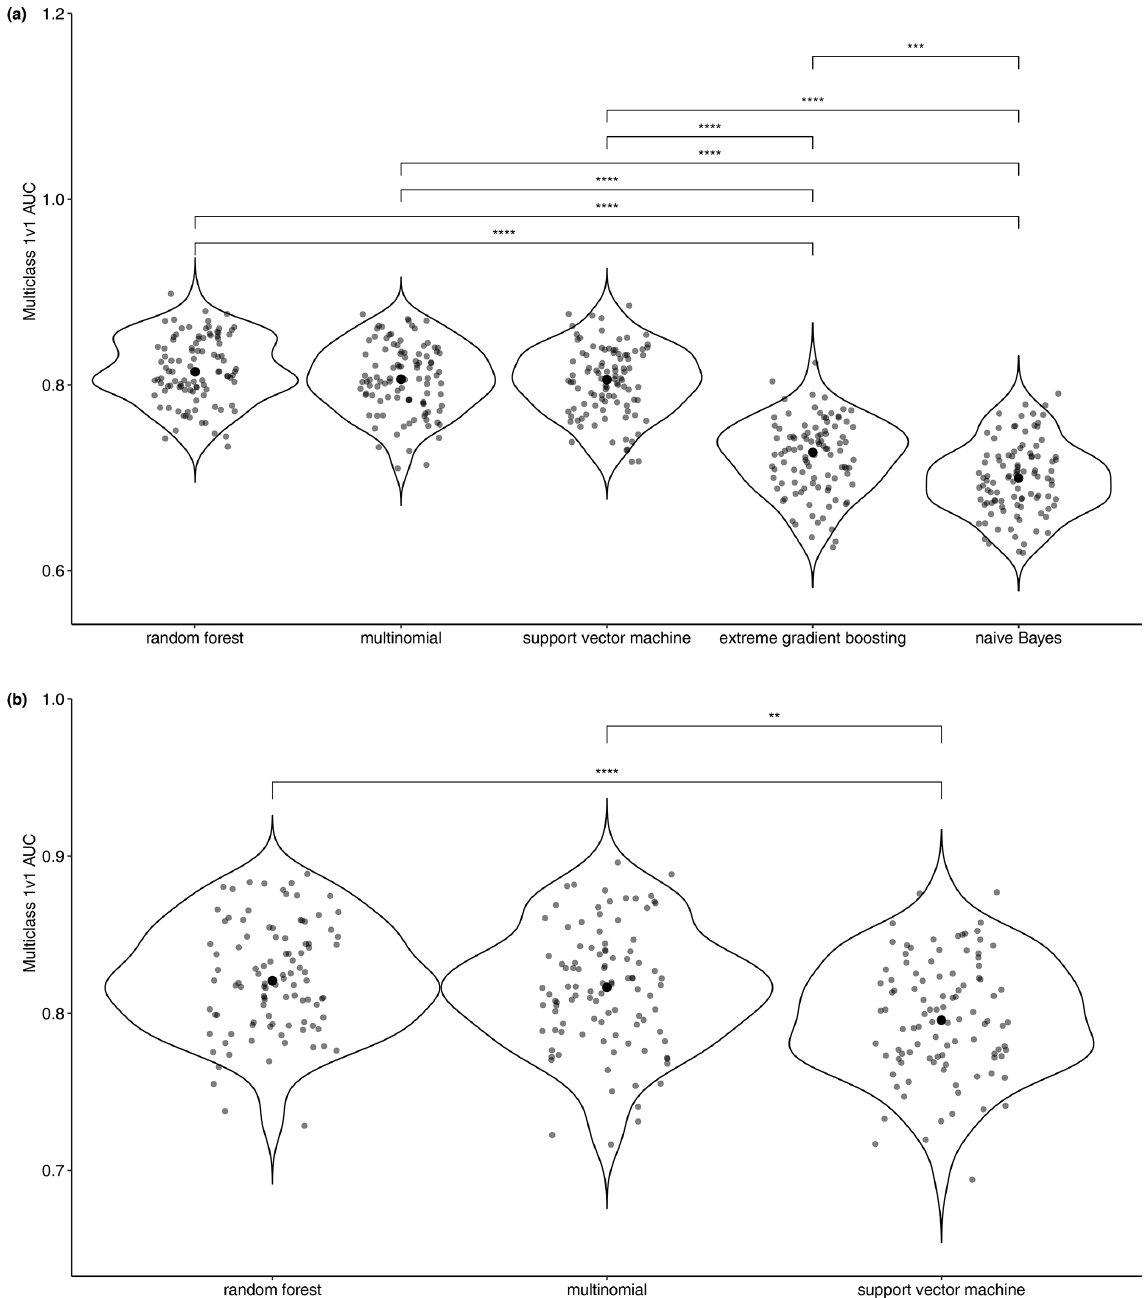
Figure 2. Machine learning performance for relevance prediction based on simple binary classification between “Relevant” and “Irrele- vant” documents ( n = 1386). (a) Performance of untuned models; (b) performance of selected tuned models. Brackets highlight statistical differences between